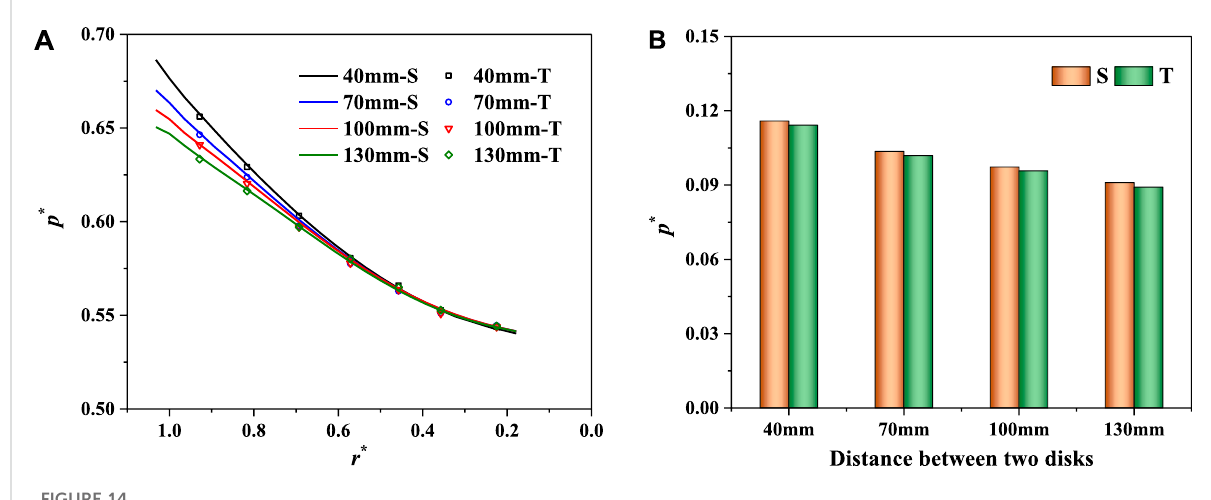
FIGURE 14 Pressure distributions under different clearance heights. (A) Pressure distributions along the radial direction. (B) Pressure drop Δ p